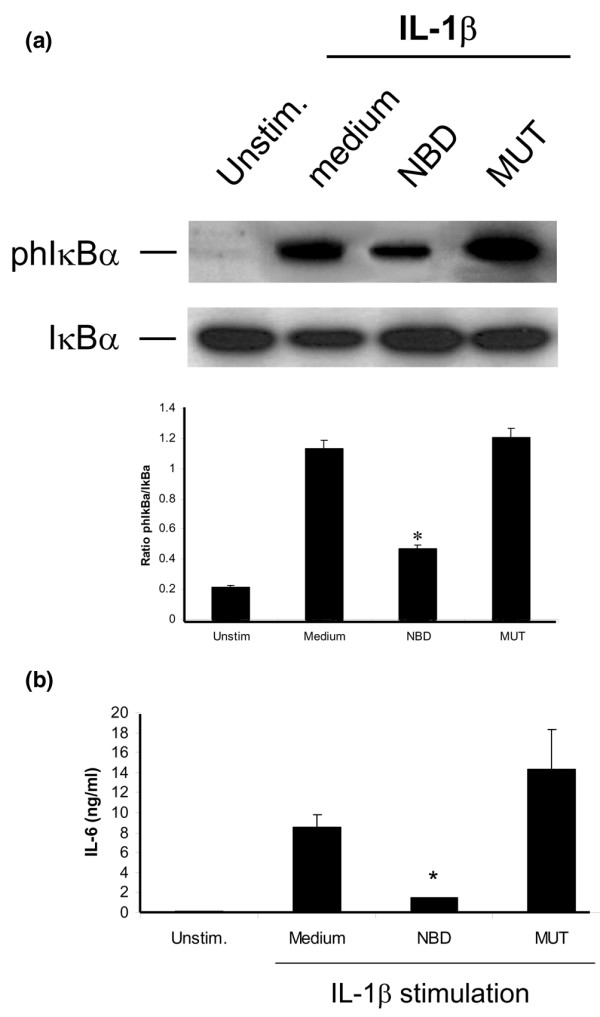
NBD peptide blocks interleukin (IL)-1-β-induced IκBα phosphorylation and IL-6 production in fibroblast-like synoviocytes (FLS). (a) FLS were pre-incubated with either NBD or mutant NBD (MUT) peptide at a concentration of 50 μM for 2 hours. Subsequently, cells were stimulated with IL-1-β (2.5 ng/ml) for 30 minutes, extensively washed, and lysed in sample buffer. Cell lysates were analyzed by Western blotting. One representative blot out of three is shown. Densitometry includes all three experiments, and data are expressed as mean ± standard error of the mean (*p < 0.01). (b) NBD peptide blocks IL-1-β-induced IL-6 production by FLS in vitro. FLS were pre-incubated with either NBD or MUT peptide at a concentration of 50 μM for 2 hours. Subsequently, cells were stimulated with IL-1-β (2.5 ng/ml). After 24 hours, supernatants were collected and IL-6 levels were measured by sandwich enzyme-linked immunosorbent assay. Data are representative of three independent experiments performed in triplicates (*p < 0.01).